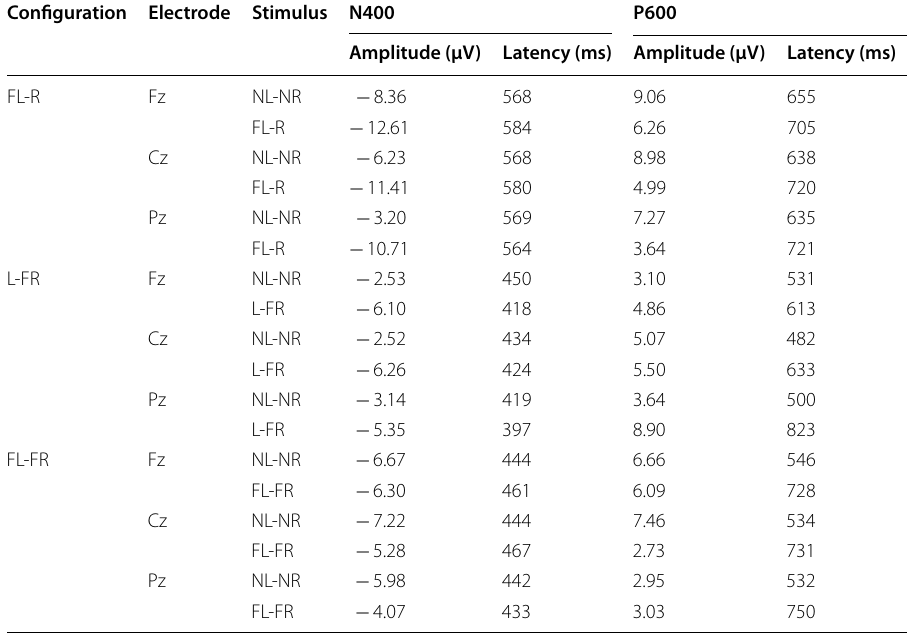
Table 2 N400 and P600 amplitudes and latencies in FL-R, L-FR, and FL-FR